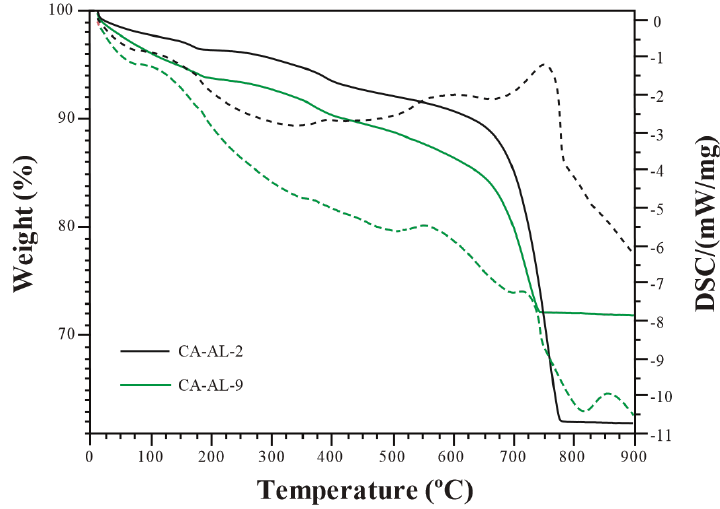
Figure 6. Thermogravimetric analyses of the binder fraction <2 µm from the vault mortar (Sample CA-AL-2 in black) and tank mortar (Sample CA-AL-9 in green).